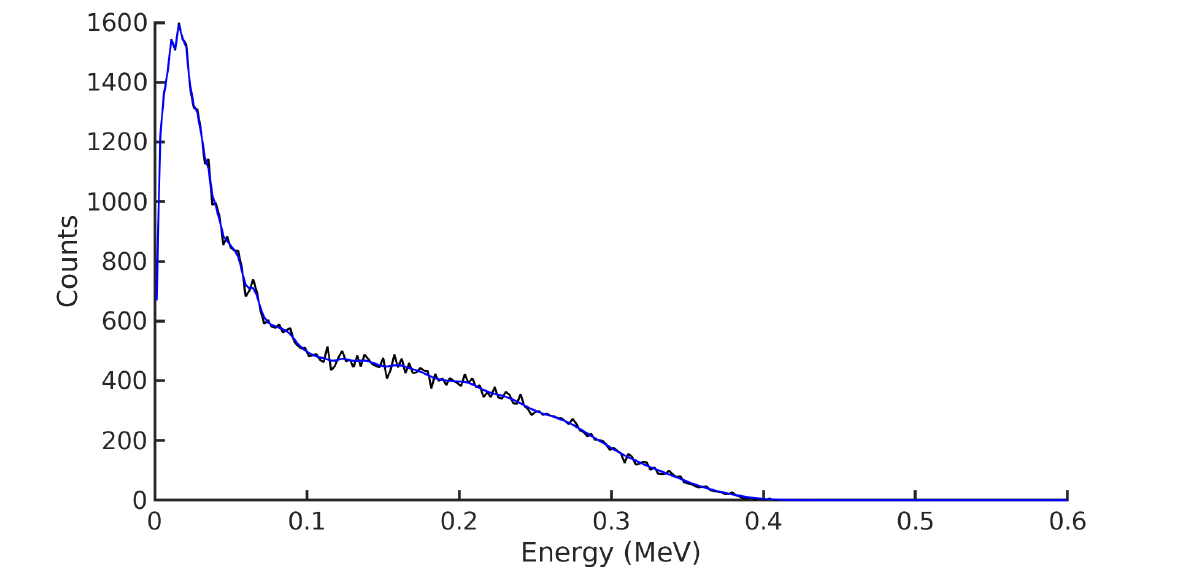
Figure 2. The simulated 90 Sr spectrum acquired with the CdTe detector in the groundwater scenario, black, with the Gaussian broadening applied,